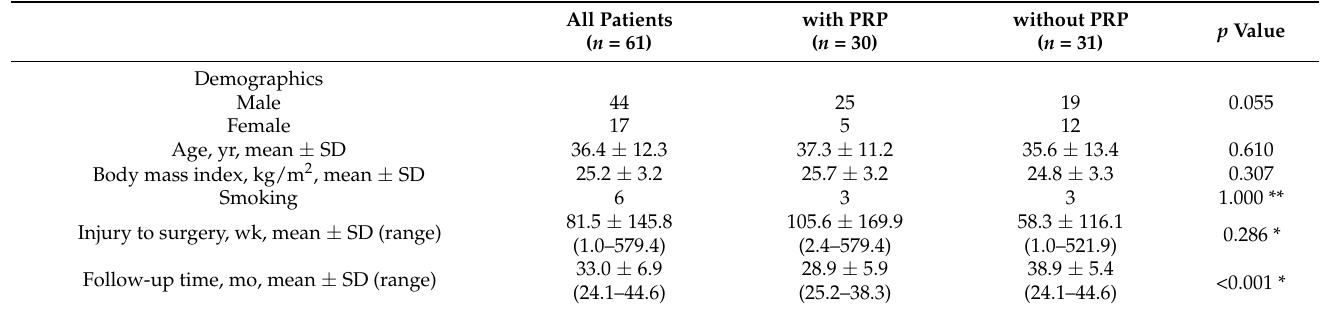
Table 1. Demographic